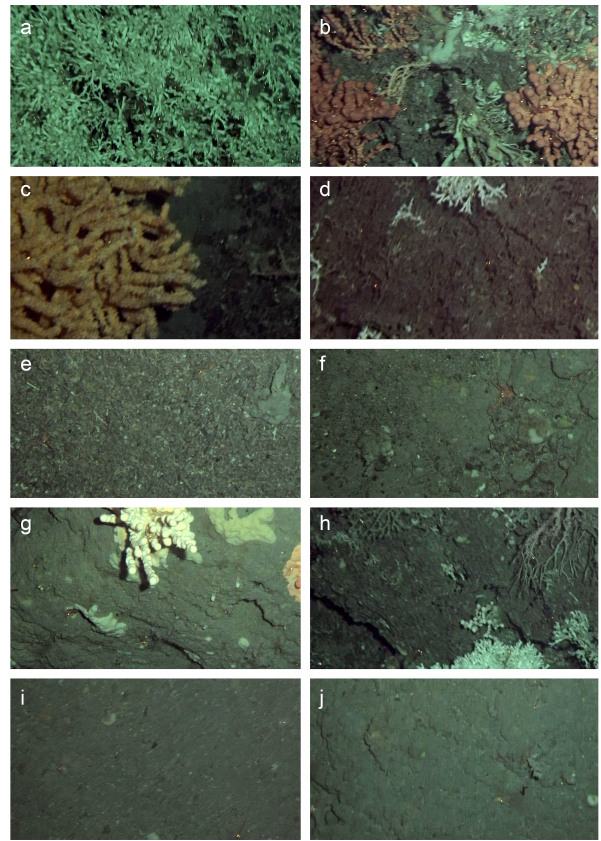
Fig. 4. Habitat categories used in this study. (a) Live Lophelia per- tusa , (b) live Paragorgia arborea (left and right of image), (c) live Primnoa resedaeformis (left of image), (d) dead scleractinian struc- ture, (e) coral rubble, (f) gravel/pebbles, (g) wall, (h) dead gor- gonian (right of image), (i) soft seabed and (j) hard